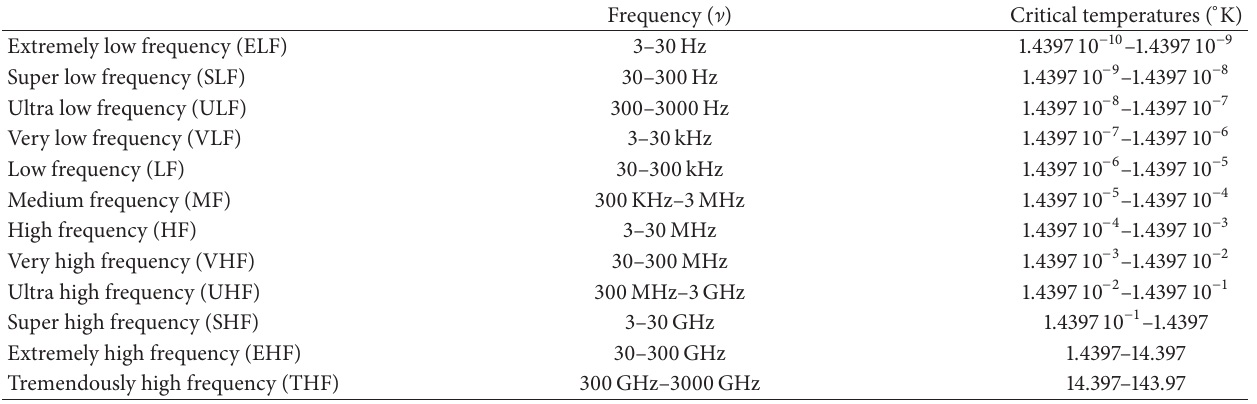
Table 1: Critical temperatures 𝑇 for typical radio waves, with ℎ/𝑘 𝐵 = 4.799 10 −11 Kelvin per second. crit